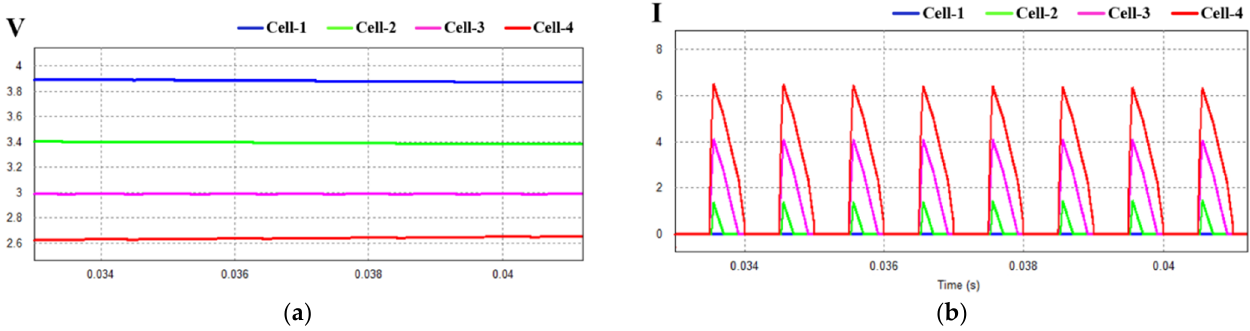
Figure 14. Cell characteristics (enlargement graph). ( a ) Cell voltage and ( b ) cell diode current.